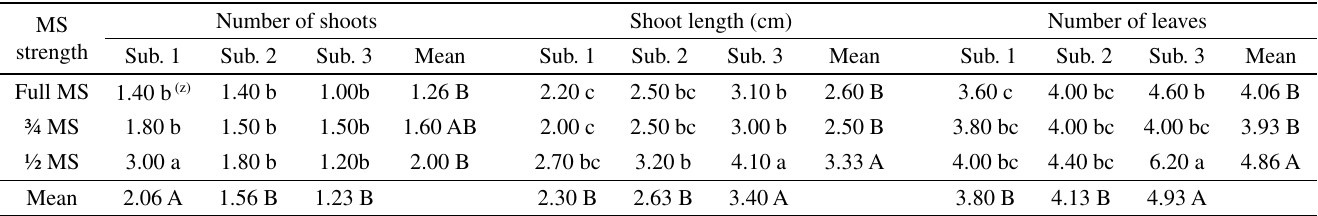
Table 1 - The interaction effect of MS salt strength and subculture number on shoot length, number of leaves, and number of shoots during multi- plication stage of Dracaena sanderiana Sander ex